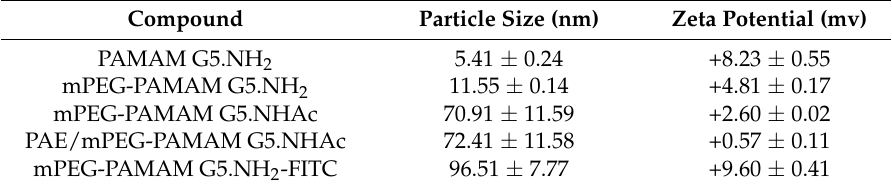
Table 2. Particle size and zeta potential of PAMAM dendrimer